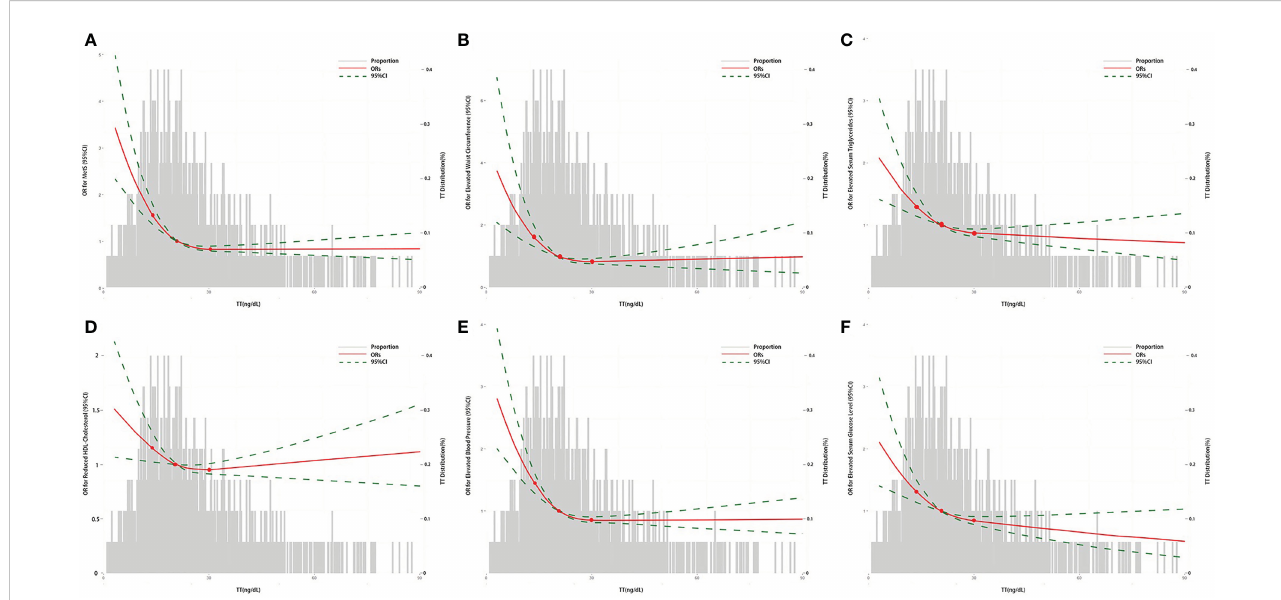
FIGURE 2 The association between TT and the ORs for MetS or its components in women by logistic regression. (A) The association between TT and the ORs for MetS; (B) The association between TT and the ORs for elevated waist circumference; (C) The association between TT and the ORs for elevated serum triglycerides; (D) The association between TT and the ORs for reduced HDL-Cholesterol; (E) The association between TT and the ORs for elevated blood pressure; (F) The association between TT and the ORs for elevated serum glucose level. The curves represent the adjusted ORs of MetS or its components by ln-transformed TT levels. The dose response association was estimated by using nonlinear dose-response relationships between ln TT and MetS or its components by the adjusted restricted cubic spline with three knots (percentile 25, 50, and 75). Model adjusted for age, race, education level, marital status, ratio of family income to poverty, BMI, alcohol use, smoking-cigarette use, depression, sleep disorders, total caloric intake per day, and NLR. TT, total serum testosterone level; MetS, metabolic syndrome; BMI, body mass index; NLR, neutrophil-to-lymphocyte ratio; OR, odds